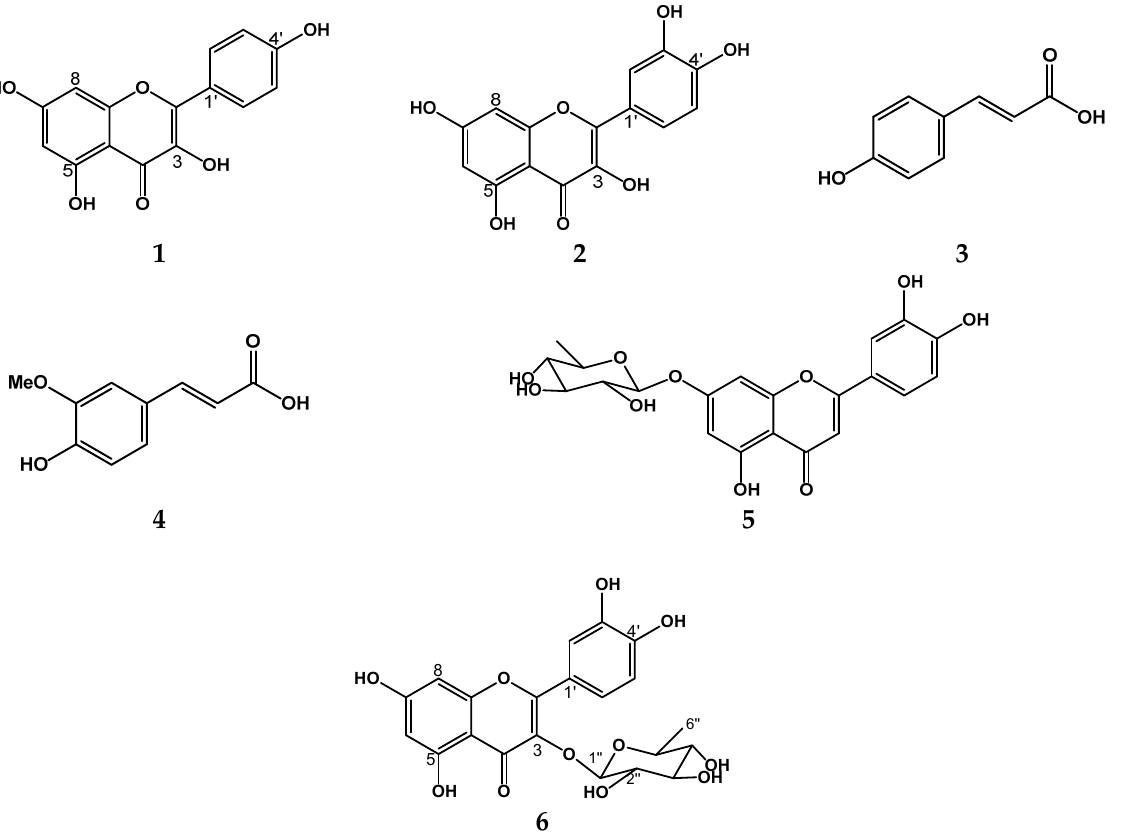
Figure 3. Structure identified in the bioactive subfractions from Pithecellobium dulce leaves.